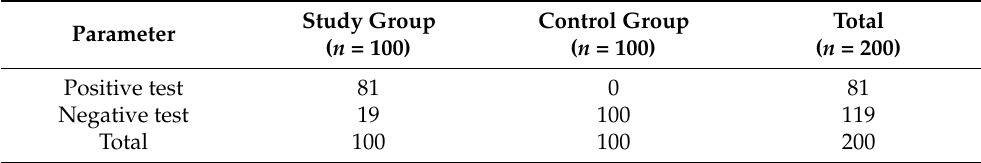
Table 2. Validation of the OSOM ® BVBLUE ® Test in comparison to Gram staining in 200 asymp- tomatic pregnant women screened for BV.